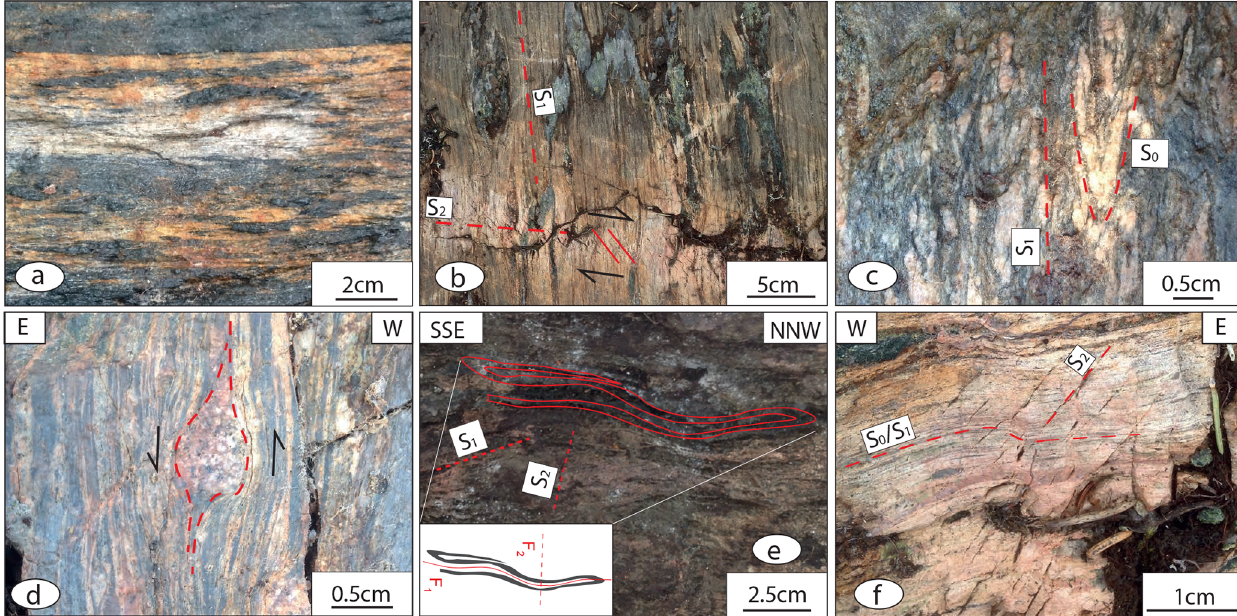
Figure 15. Field images of characteristics of the Fjällåsen–Allavaara key area. (a) High-intensity foliation, X721253 Y7473543. (b) Iso- clinally folded quartz and amphibole veins with related axial planar S 1 cleavage. Brittle-plastic S 2 with dextral sense of shear, X721192 Y7473733. (c) Tight F 1 folding of S 0 , X714642 Y7479559. (d) Asymmetric lithic sigma clast viewed along steep, north-plunging stretching lineation, X715483 Y7478182. (e) Isoclinal F 1 gently refolded by F 2 , X713553 Y7480026. (f) Gentle F 2 folding of S 0 /S 1 with associated brittle-plastic S 2 , X721194 Y7473733. Coordinates: Sweref99.